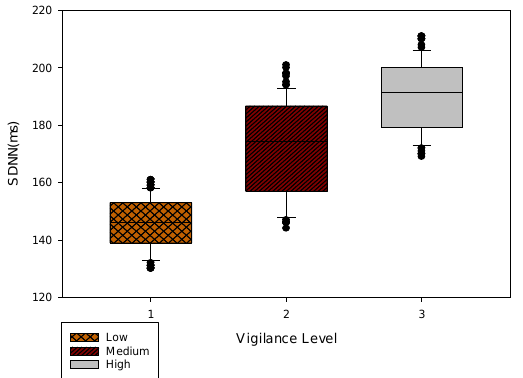
Figure 8. SDNN numerical statistics results.